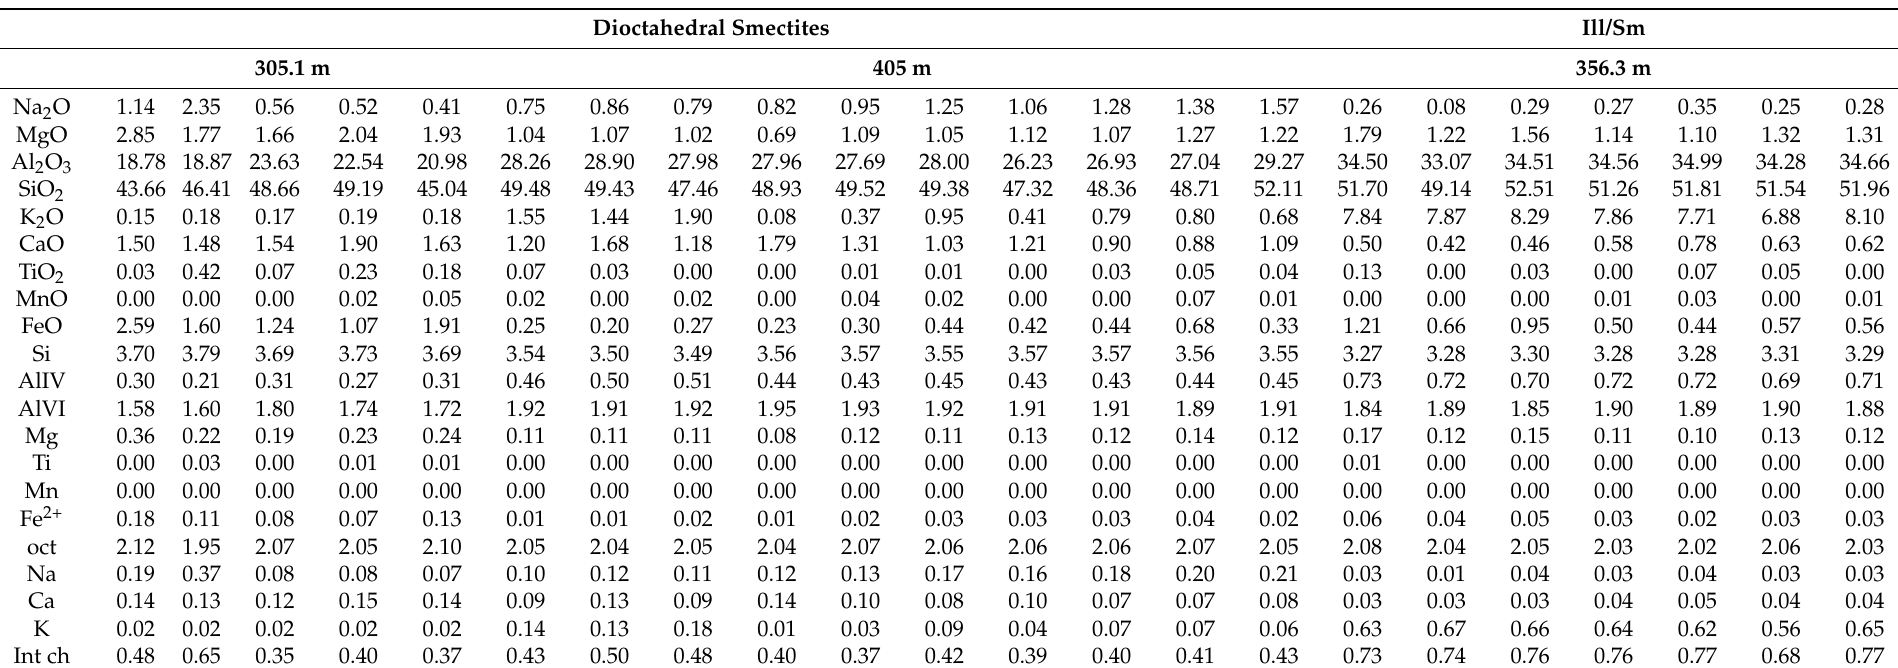
Table 4. Representative chemical compositions of dioctahedral smectites and Ill/Sm. Structural formulas are calculated per half formula unit (11O). Analyses obtained by EDS on polished thin